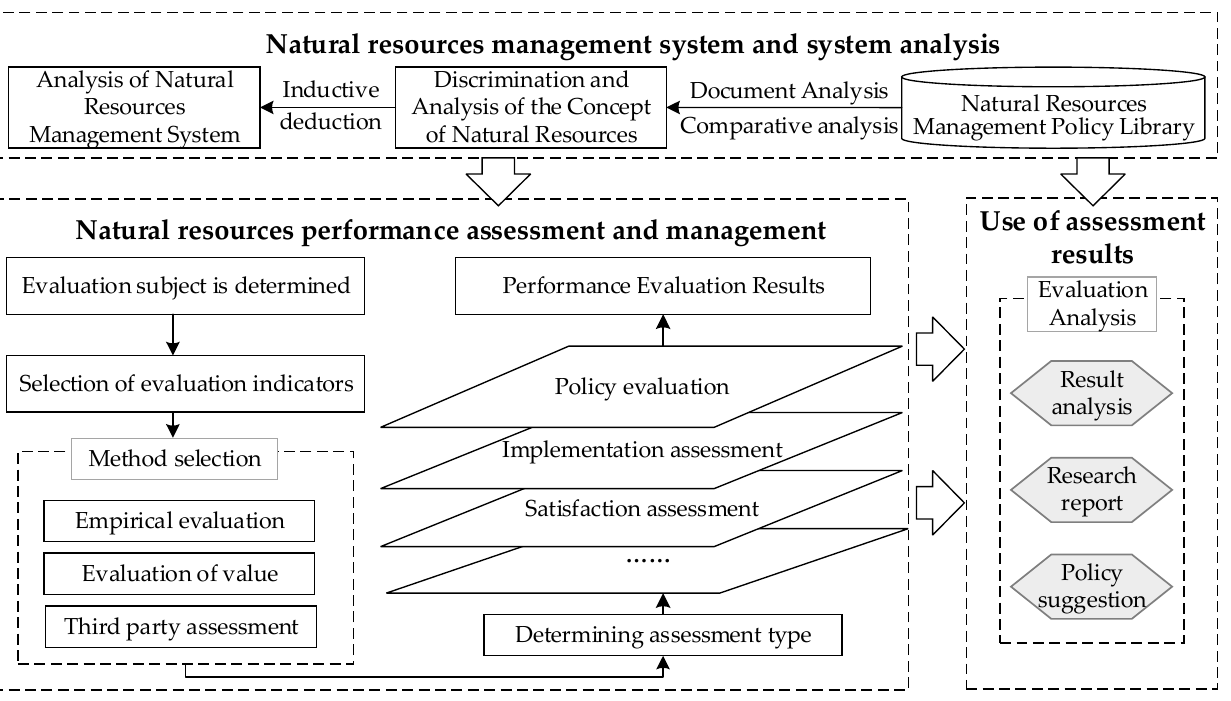
Figure 3. Theoretical Framework of research on performance management of natural resources for China.